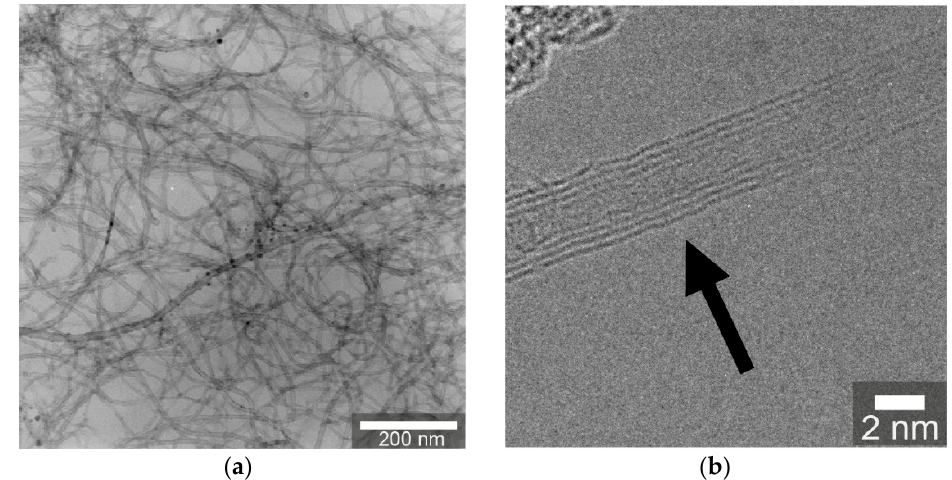
Figure 1. TEM images of fCNT: ( a ) general view; ( b ) image showing that the fCNT is formed by four walls.